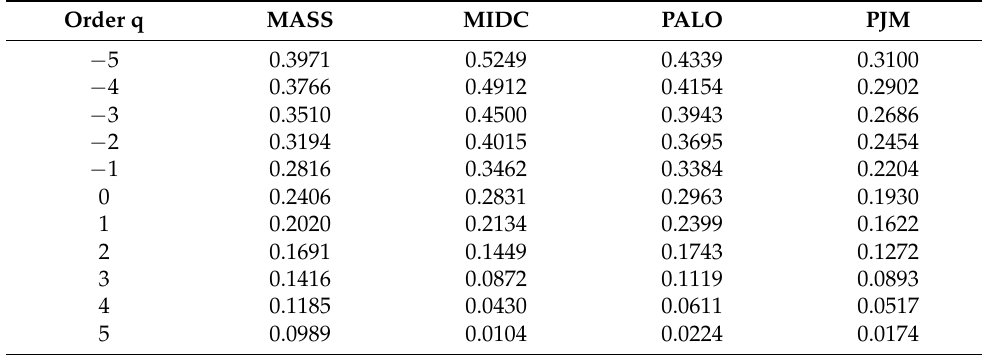
Table 3. Generalized Hurst exponents ranging from q = − 5 to q = 5.